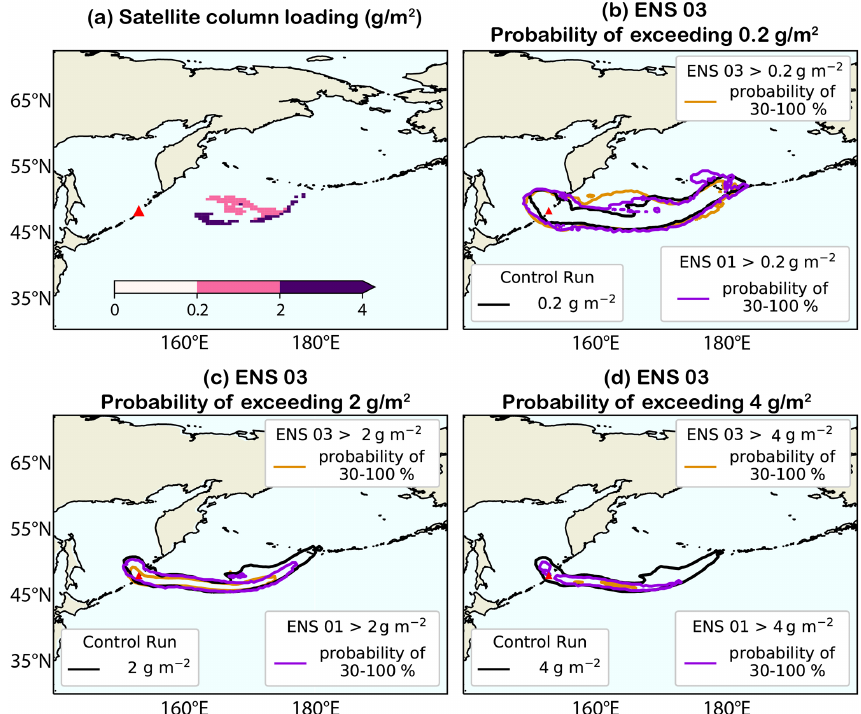
Figure 7. (a) Satellite-detected column loading at T 3 (22 June 2019 18:00UTC) shown in filled contours. Probability of exceedance maps for ENS03 at T 3 for column loading thresholds of (b) 0.2gm − 2 , (c) 2gm − 2 , (d) 4gm − 2 shown with dashed brown contour (30% probability region – the region within the brown line goes from 30% up to 100%). The black contour in (b) , (c) , and (d) shows the relevant column loading threshold for the control run. The purple contours show the 30% probability region for ENS01 of exceeding the relevant column loading threshold (the region within the purple line goes from 30% up to 100%). For generating the purple contours, members from the prior ensemble were retained by verifying ENS01 with observations at T 3 (a) and using the same HR and MPD thresholds for which ENS03 has been evaluated (Table 2) to ensure a fair comparison between the prior and posterior ensembles. See Fig. C1 in Appendix C for the same probability maps including the 0%–30% probability regions for ENS03.